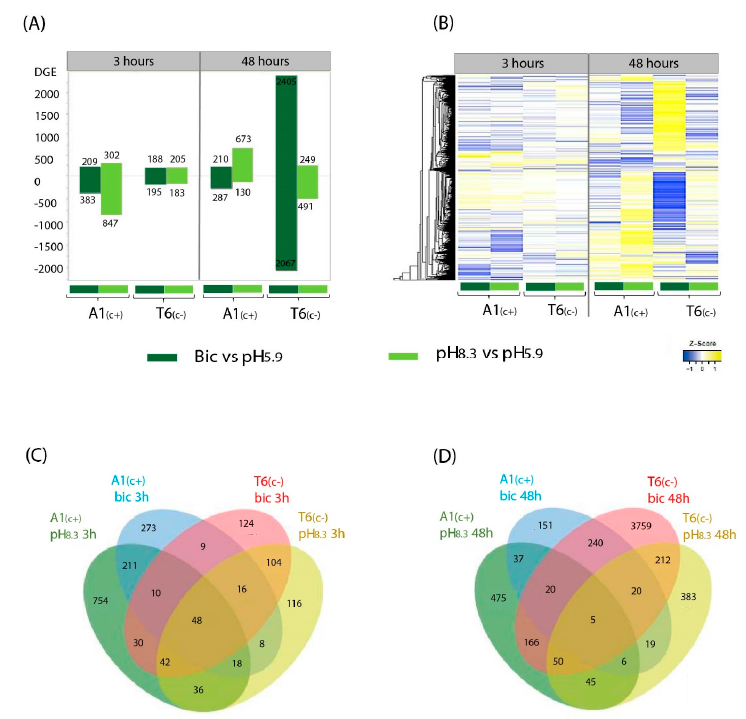
Figure 2. Compared transcriptomic profiles under different alkalinity treatments at two time points. Differential expressed genes (DEGs) bar plot ( A ), heatmap profile ( B ), and Venn diagram at 3h ( C ) and 48 h ( D ) of the pairwise comparations pH and 48 h ( D ) of the pairwise comparations pH 8.3 vs. pH 5.9 and bic vs. pH 5.9 in A1 (c+) and T6 8.3 vs. pH 5.9 and bic vs. pH 5.9 in A1 (c+) and T6 (c − ) demes. DEGs were filtered at log fold change (LFC > 1, LFC < − 1), and − 1), and adjusted p -value < 0.05. adjusted p -value < 0.05. Yellow areas indicate upregulated genes and blue areas indicate downregulated genes. (c − ) demes. DEGs were filtered at log fold change (LFC > 1, LFC < Yellow areas indicate upregulated genes and blue areas indicate downregulated